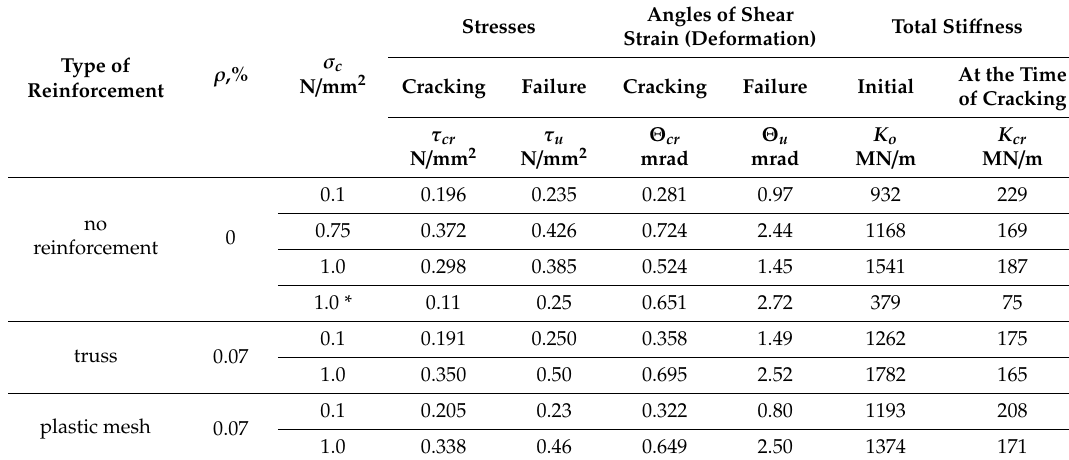
Table 6. Test results for walls made of AAC masonry units.